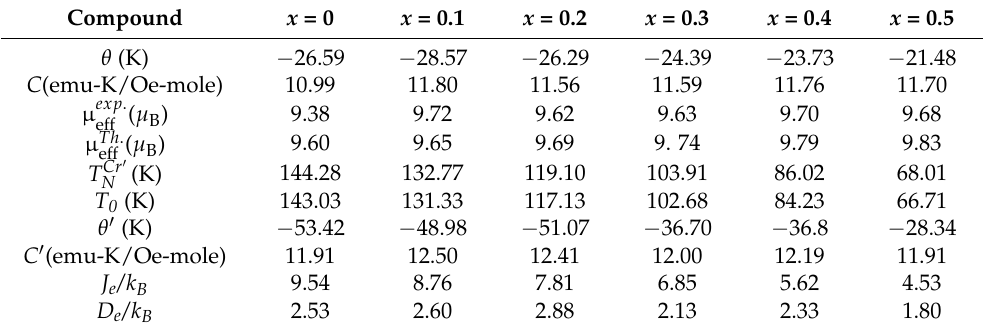
Table 3. Magnetic parameters: Curie constant C (emu-K/Oe-mole), Weiss temperature θ (K), experi- mental and theoretical effective magnetic moment obtained from Curie–Weiss fitting, and T Cr (cid:48) θ (cid:48) (K), C (cid:48) (emu-K/Oe-mole) , fitting paramete r T 0 (K) and symmetric and antisymmetric exchange constant obtained from modified Curie–Weiss fitting of inverse susceptibility vs. temperature